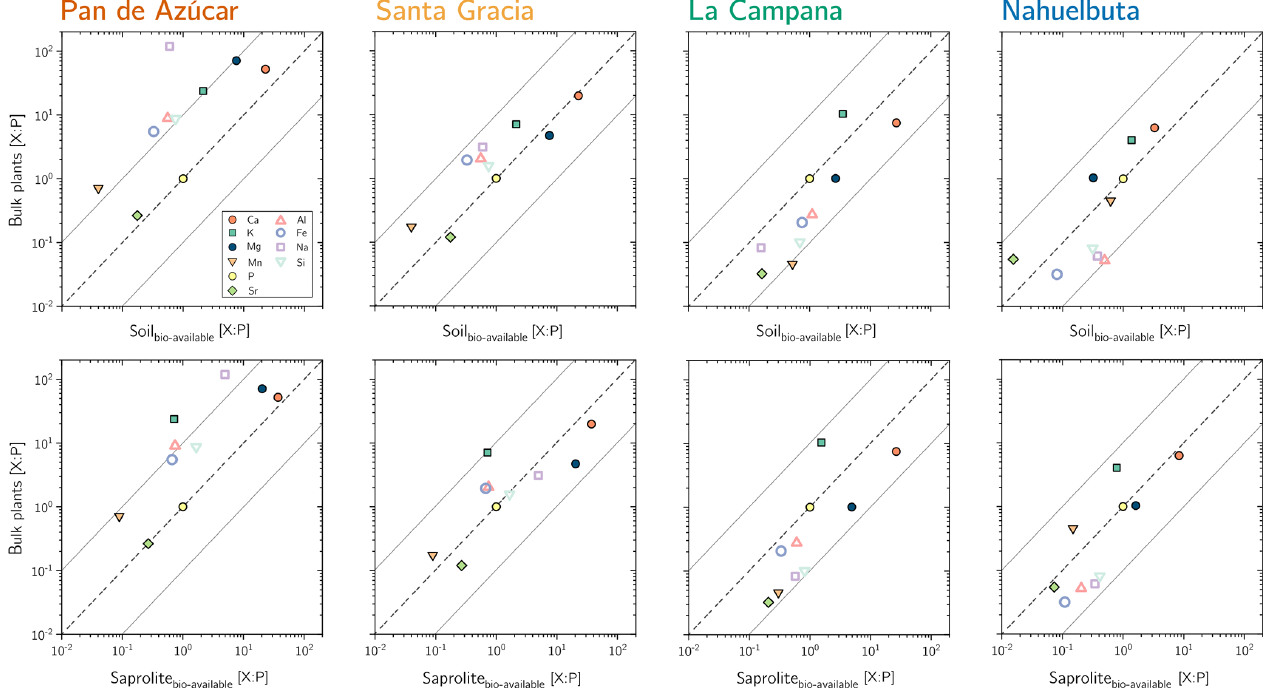
Figure 6. P-normalized element composition for bulk plants and the bioavailable fraction in soil and saprolite. Solid grey lines reflect the 10 × P and 0 . 1 × P concentration, respectively. Note that with increasing recycling from Santa Gracia to Nahuelbuta, the bioavailable fractions’ X :P successively approaches X :P in vegetation. Table 5. Nutrient recycling factors in Pan de Azùcar, Santa Gracia, La Campana, and Nahuelbuta. Shown in brackets are the Rec X prior corrections for atmospheric